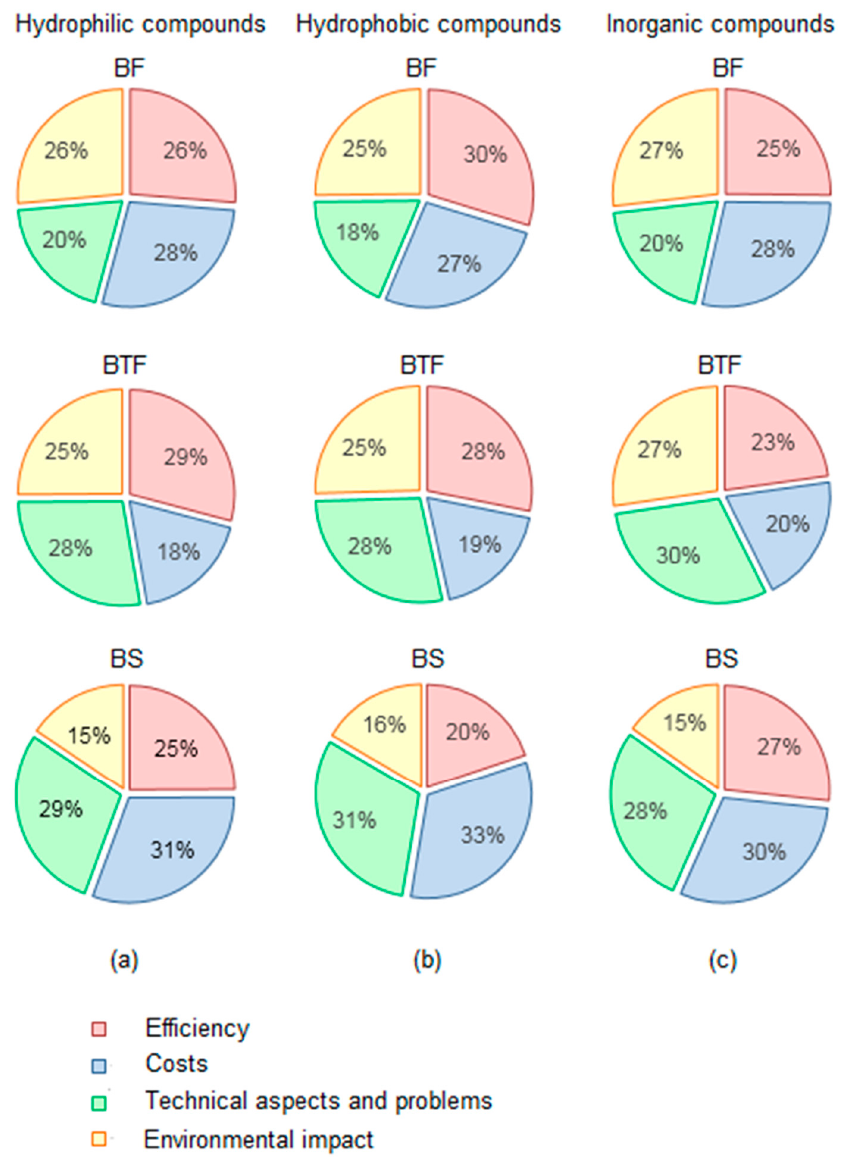
Figure 4. Distribution of alternative results related to different criteria for: ( a ) hydrophilic compounds, ( b ) hydrophobic compounds and ( c ) inorganic compounds.